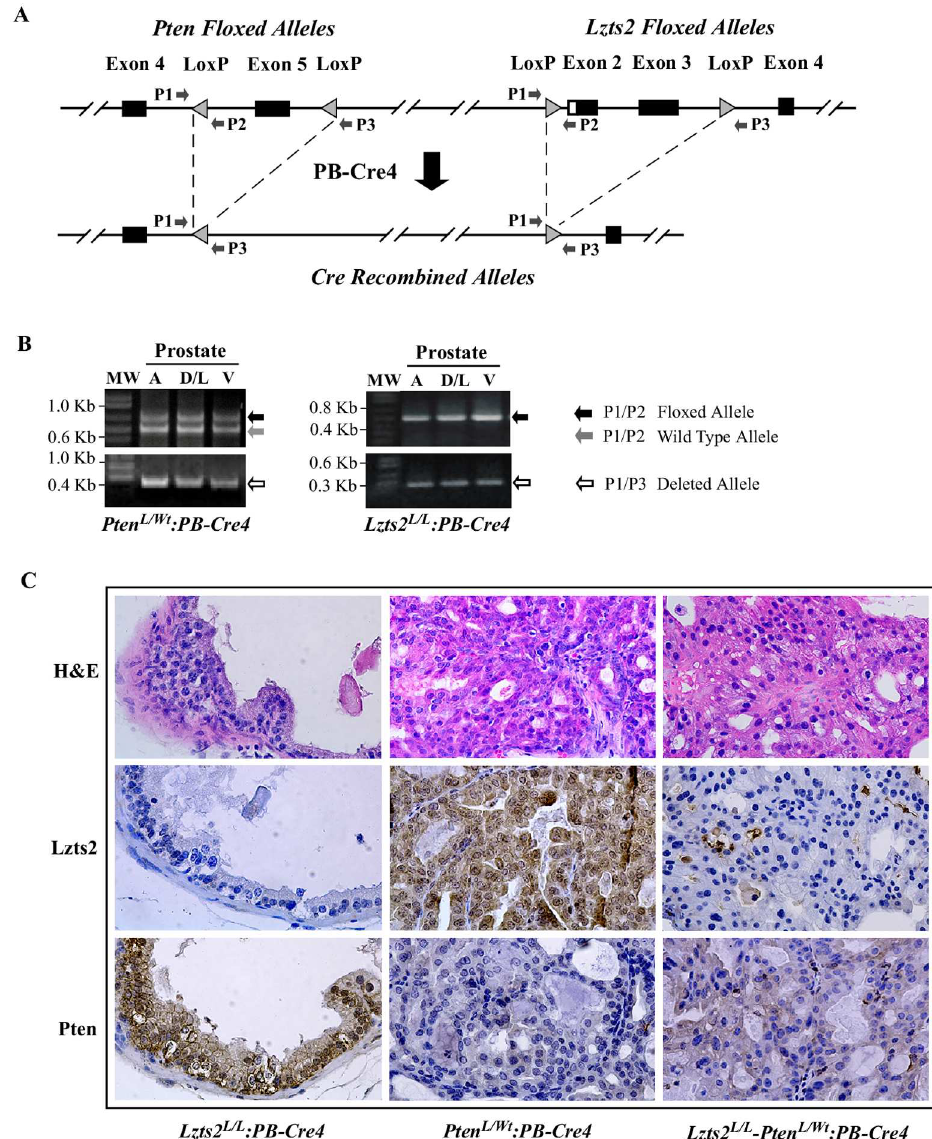
Fig 3. Generation of mice with prostate-specific Lzts2 and Pten deletion. (A) Schematicrepresentation of Lzts2 and Pten compoundmice. On chromosome 19, loxP sites flank exon 5 of the pten gene and exons 2 and 3 of the lzts2 gene. Crossingwith PB-Cre mice results in prostate-specific recombination of the loxP sites and removalof these exons from this locus. (B) Genomic PCR analysisof Lzts2 and Pten allelesin prostate tissues using specific primers as detailedin (A). (C) Histologicaland immunohistochemicalanalysisof 6–8 month old Lzts2 LoxP/LoxP : PB-Cre4 , Pten loxP/Wt : PB-Cre4 , and Lzts2 LoxP/LoxP -Pten loxP/Wt : PB-Cre4 mice. Top panel depicts H&E staining of prostate tissues. Immunohistochemistry of Lzts2 (middle)and Pten (lower) on sequential sections are shown below.